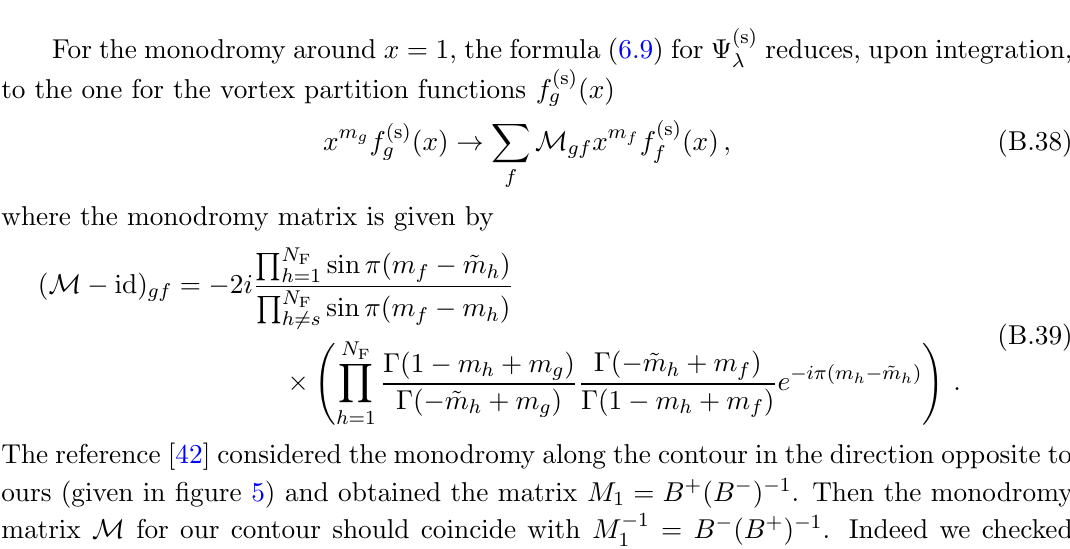
Figure 5 . Analytic continuation path for the non-trivial loop counterclockwise around the singu- larity at x =